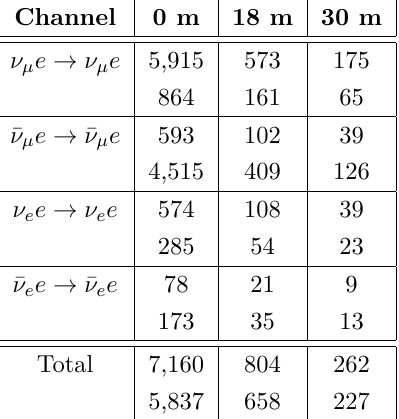
Table 1 . The total expected number of ν − e events per year for different on/off axis locations for each flavor. In each entry the top (bottom) number belongs to the (anti)neutrino mode. runs for 7 years equally in the neutrino and anti-neutrinos modes ( 3 . 5 years each), but all the time in the on-axis location (0 m); ii) The experiment runs for 3 . 5 years in the on-axis location (0 m), and 3 . 5 years in the off-axis locations of 18 m and 30 m of the